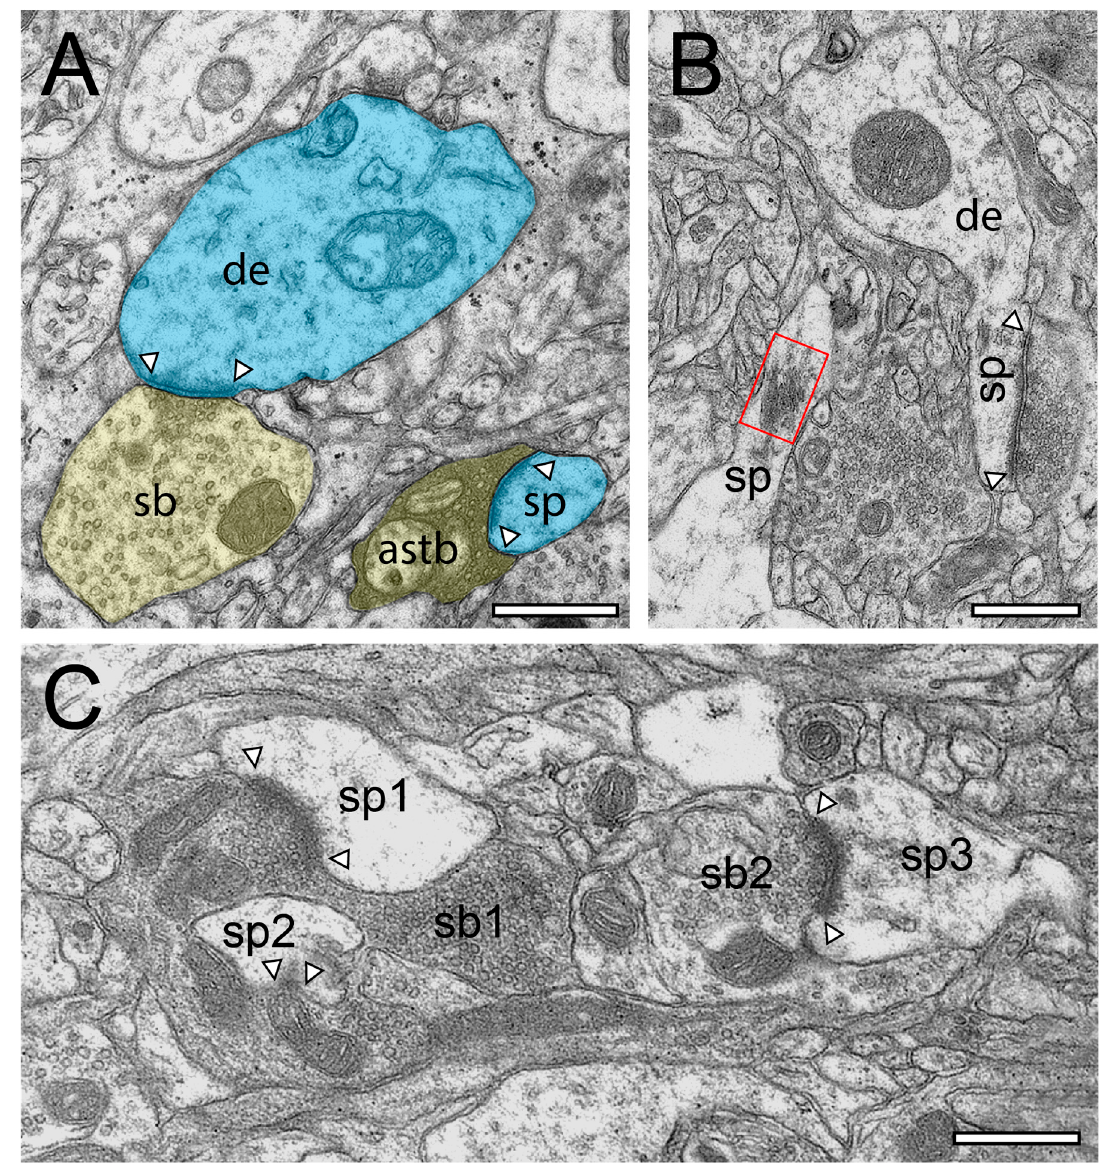
Figure 5. Structural characteristics of SBs in the human TLN as revealed by TEM. ( A ), EM micrograph of SBs (sb, transparent yellow) terminating on a dendrite (de, transparent blue) with an adjacent “astrocytic bouton” (astb, transparent yellow) terminating on a small dendritic spine (transparent blue) in L3 of the gyrus temporalis medialis. Note the dark appearance typical for astrocytes and the content of vesicles containing gliotransmitter. AZs are marked by arrowheads. ( B ), two spines (sp) with a relatively large spine head and short spine necks one containing a prominent spine apparatus (framed area) in L6 of the gyrus temporalis medialis. The right spine with a large macular, non-perforated AZ (arrowheads) receiving input from an end terminal SB, whereas on the left spine display, no obvious contact is visible. ( C ), Large SBs (sb1) invaginating two spines (sp1, sp2) in L2 of the gyrus temporalis inferior next to another spine (sp3) receiving input from another SB (sb2). AZs are marked by arrowheads. Scale bar in ( A – C ), 0.5 µm.